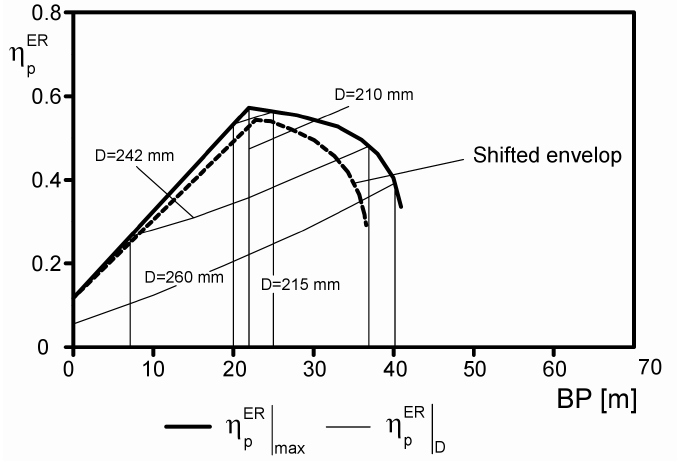
Figure 6. Efficiency variability of different machines with ER—modification of the VOS solution.